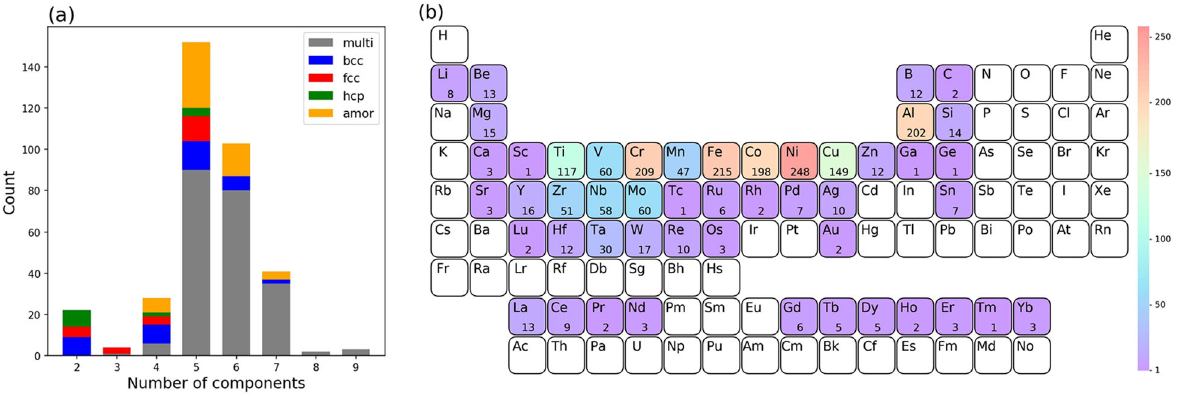
Fig. 5 Statistics of the 355 HEAs in the dataset. a The numbers of binary to nonary HEAs and the proportions of different phases. b The occurrence numbers of elements in the dataset are given under periodic table background. The blank squares, e.g., squares for noble gases, signify the elements not in the